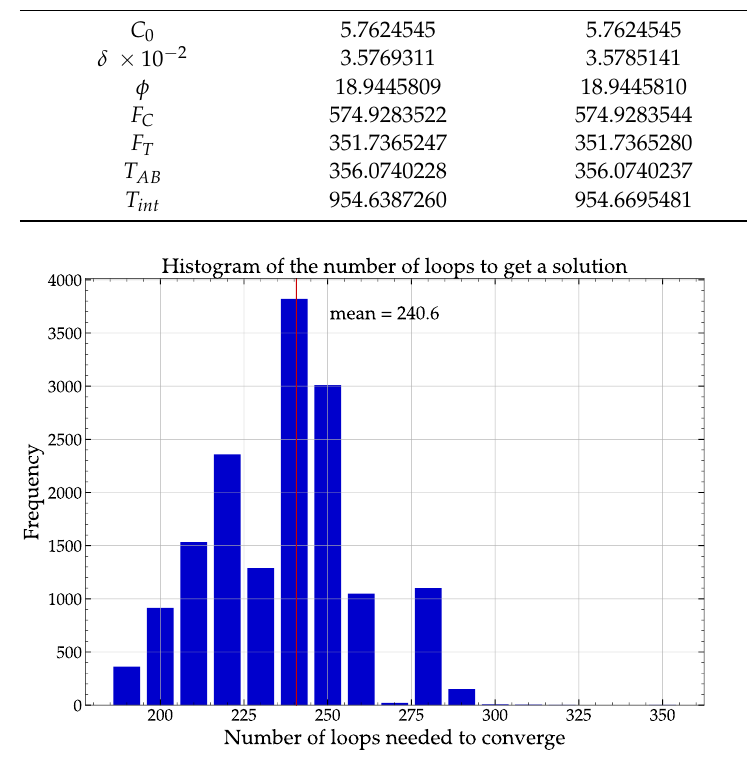
Figure 5. Histogram of the total number of loops to get a